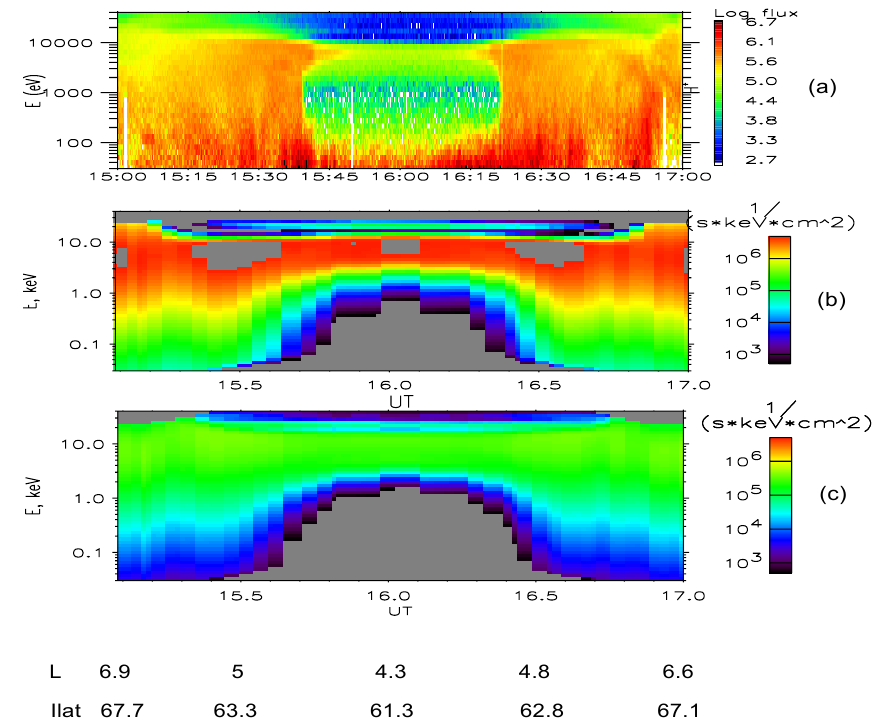
Fig. 10. Real and simulated spectra (17h of tracing, same flux scale for each panel) for the 22 February 2002 using different parameters models: (a) Observed spectrogram by CODIF/SC4; (b) Simulations under a Volland-Stern electric field and TSY89 magnetic field model, both K p dependents, LANL MPA data as source inputs and assuming a Kappa-like distribution; (c) Same as (b) but assuming a Maxwellian distribution function. The color scale has been defined to be the same in all three